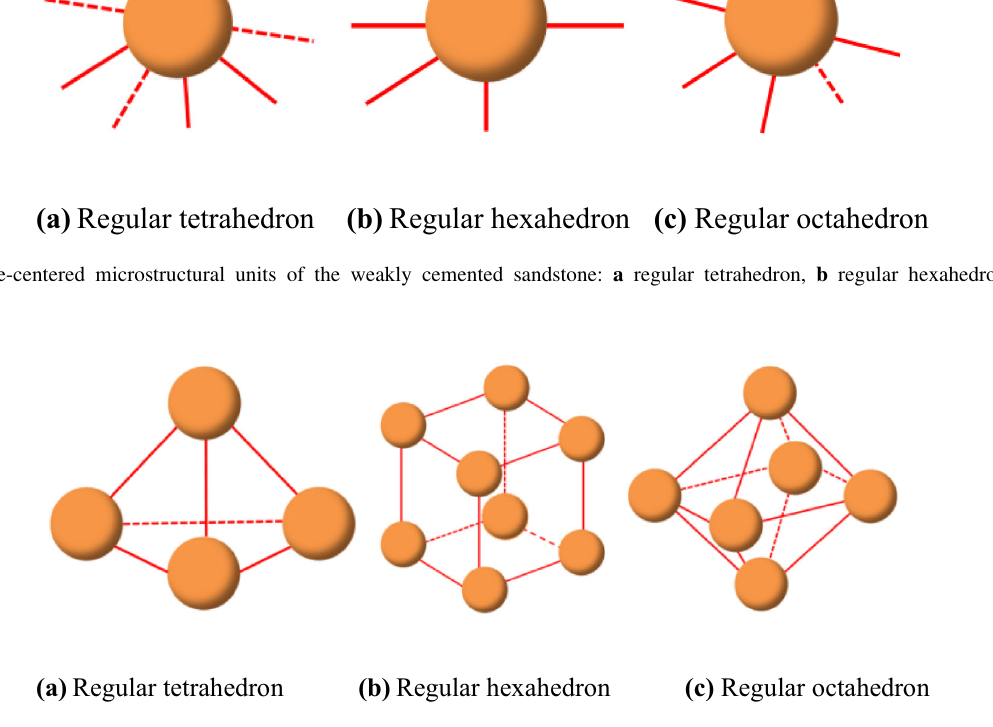
Fig. 4 Pore-centered microstructural units of the weakly cemented sandstone: a regular tetrahedron, b regular hexahedron, c regular